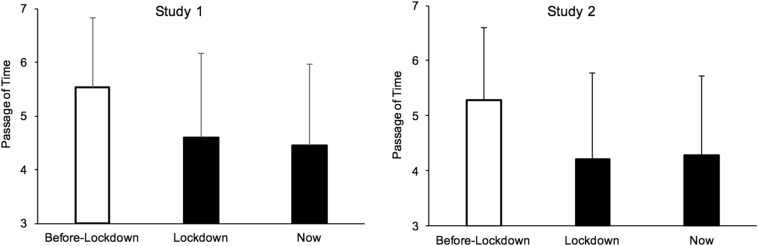
Mean rating of the passage of time for before, during the lockdown and for the present period (Now).